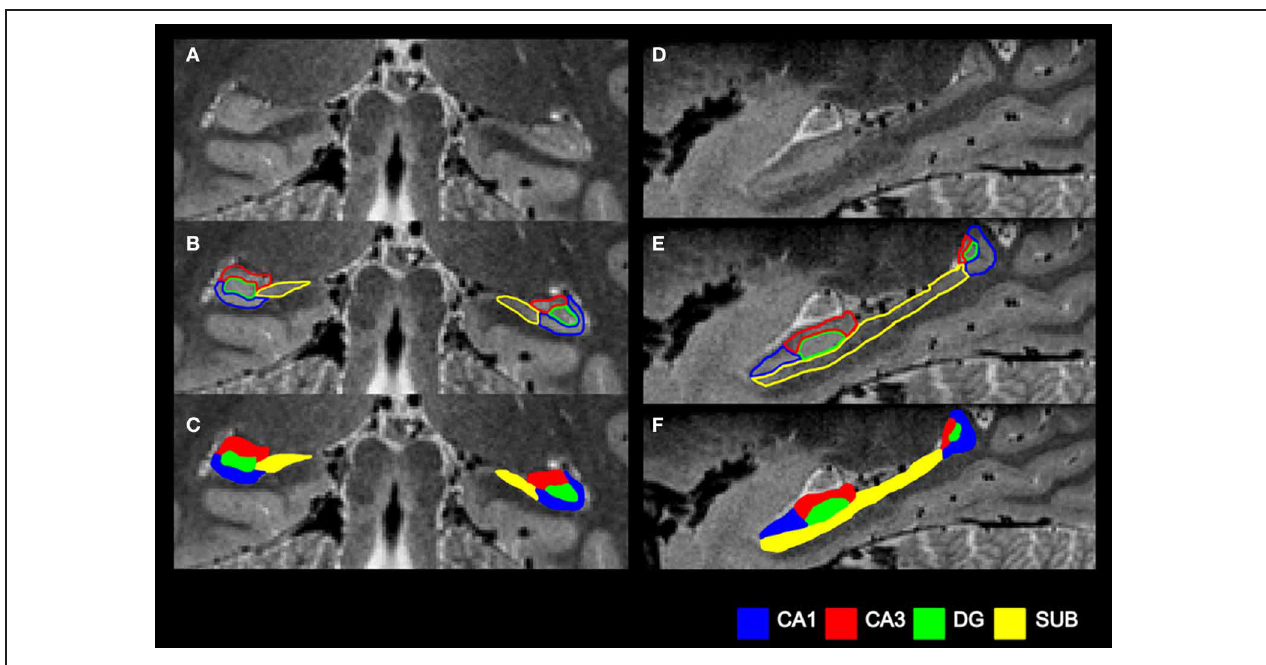
FIGURE 4 | Summary of the subfield segmentation procedure. (A) An example coronal slice before segmentation. (B) The same coronal slice with the subfield boundaries demarcated. (C) The final subfield segmentation of